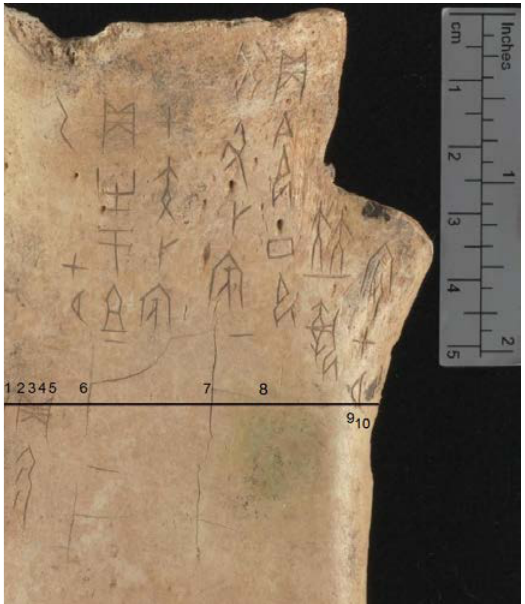
Fig. 1. Jiaguwen example ( 甲骨文 – “writing on turtle shells”): hieroglyphic inscriptions fixing the results of fortune telling or predictions [7].